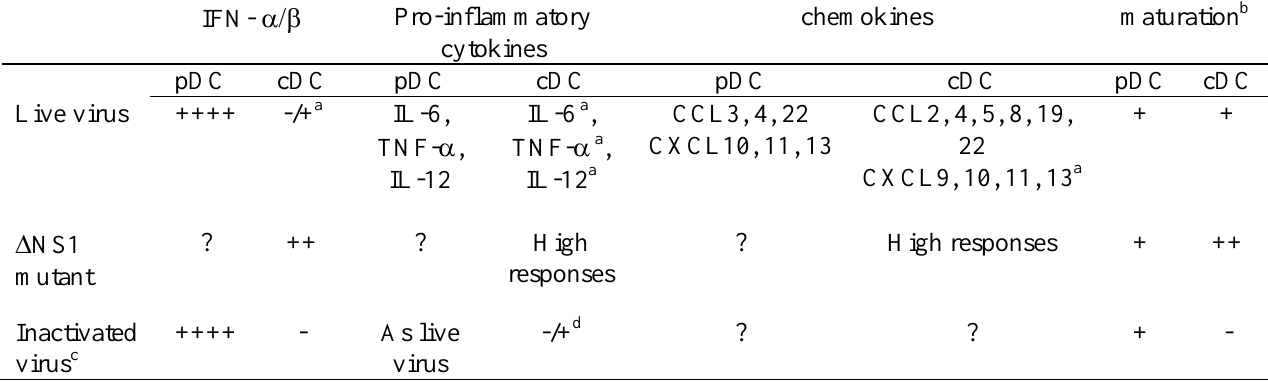
Table 1. Innate immune responses involving DC induced by